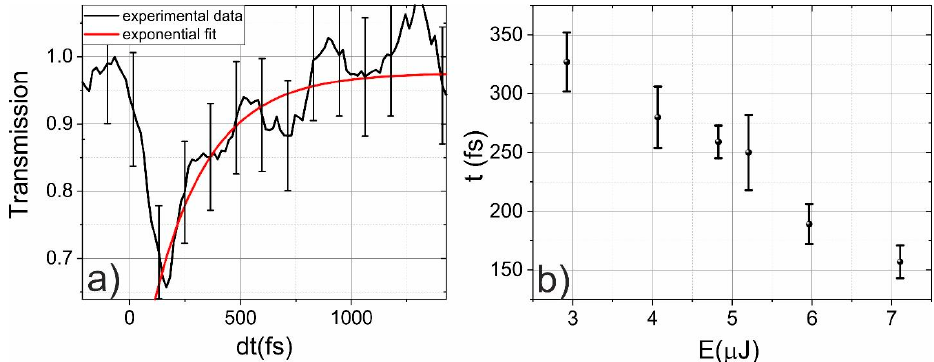
Figure 3. ( a ) Dynamics of the change in absorption in the laser-induced plasma. The red line shows exponential fi tt ing. ( b ) Dependence of plasma relaxation time on the laser pulse energy.